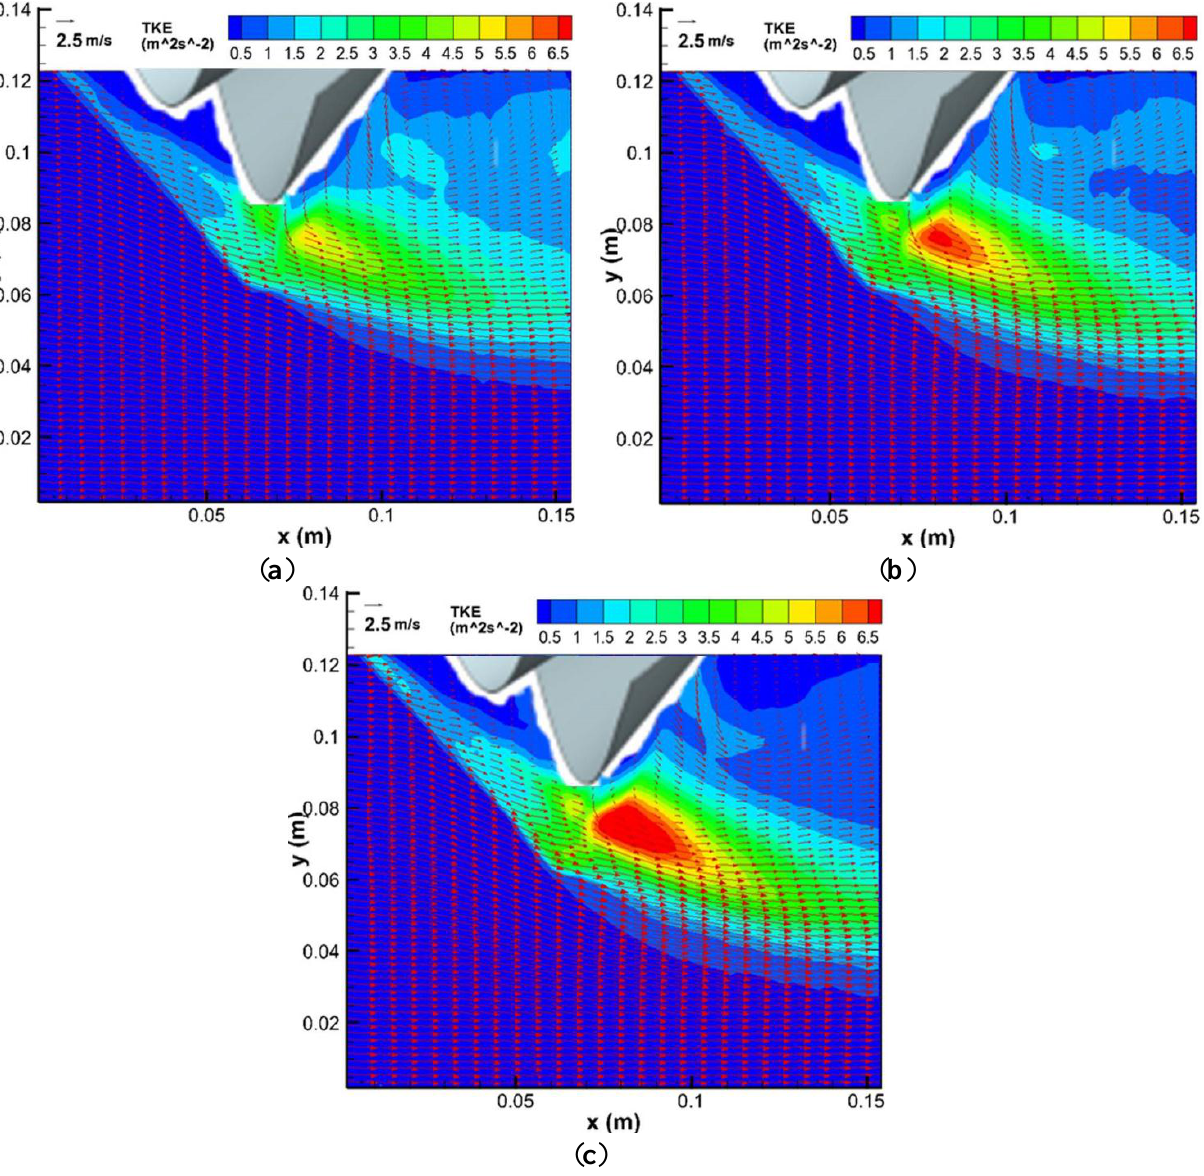
Figure 12. Turbulent kinetic energy distribution ( a ) 3.5 m/s and 300 rpm; ( b ) 4 m/s and 400 rpm; ( c ) 5 m/s and 500